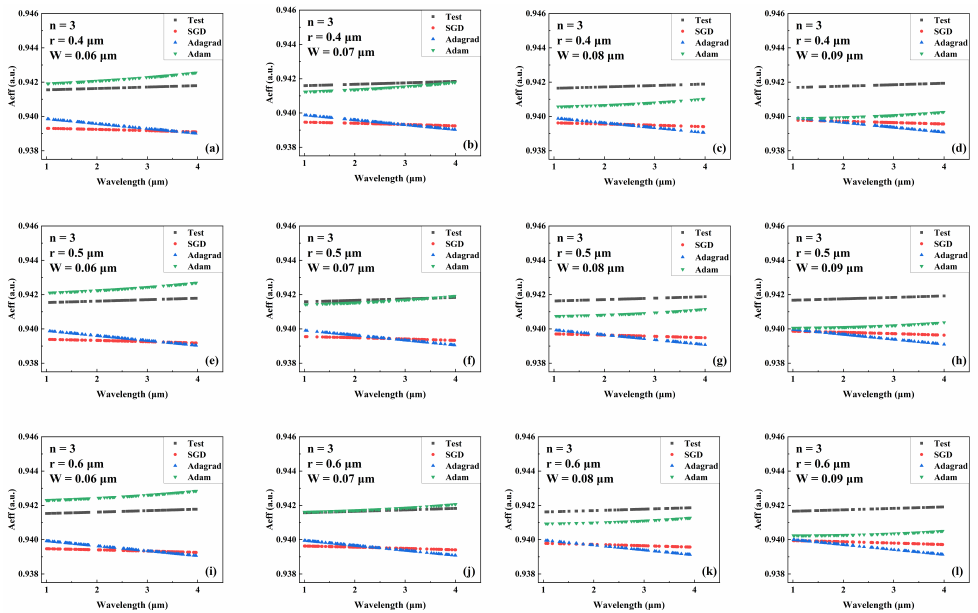
Figure 4. Comparison of the predicted and actual values of A ef f in the test data set of the network model trained by different optimizers for different combinations of core radius and cantilever width (number of cantilevers: 3). ( a ) r = 0.4 µ m, W = 0.06 µ m. ( b ) r = 0.4 µ m, W = 0.07 µ m. ( c ) r = 0.4 µ m, W = 0.08 µ m. ( d ) r = 0.4 µ m, W = 0.09 µ m. ( e ) r = 0.5 µ m, W = 0.06 µ m. ( f ) r = 0.5 µ m, W = 0.07 µ m. ( g ) r = 0.5 µ m, W = 0.08 µ m. ( h ) r = 0.5 µ m, W = 0.09 µ m. ( i ) r = 0.6 µ m, W = 0.06 µ m. ( j ) r = 0.6 µ m, W = 0.07 µ m. ( k ) r = 0.6 µ m, W = 0.08 µ m. ( l ) r = 0.6 µ m, W = 0.09 µ m.